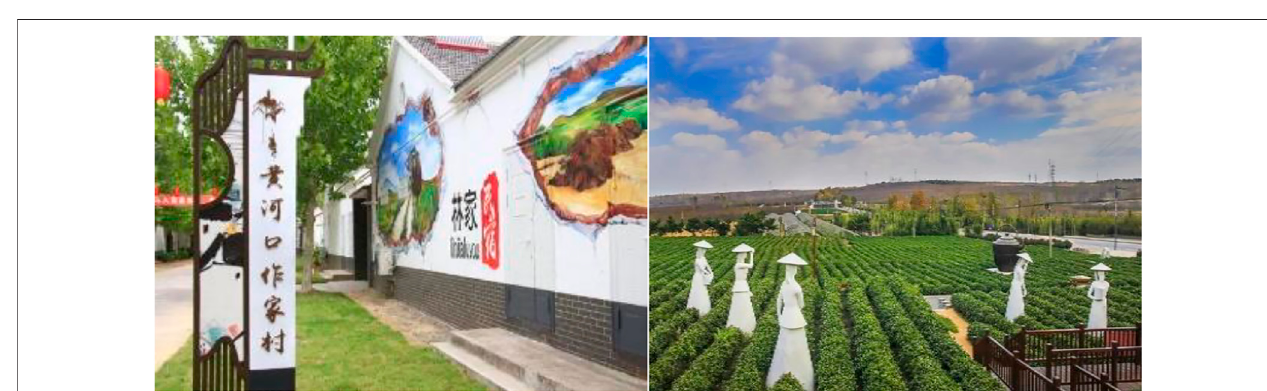
FIGURE 4 | Agriculture-tourism town.